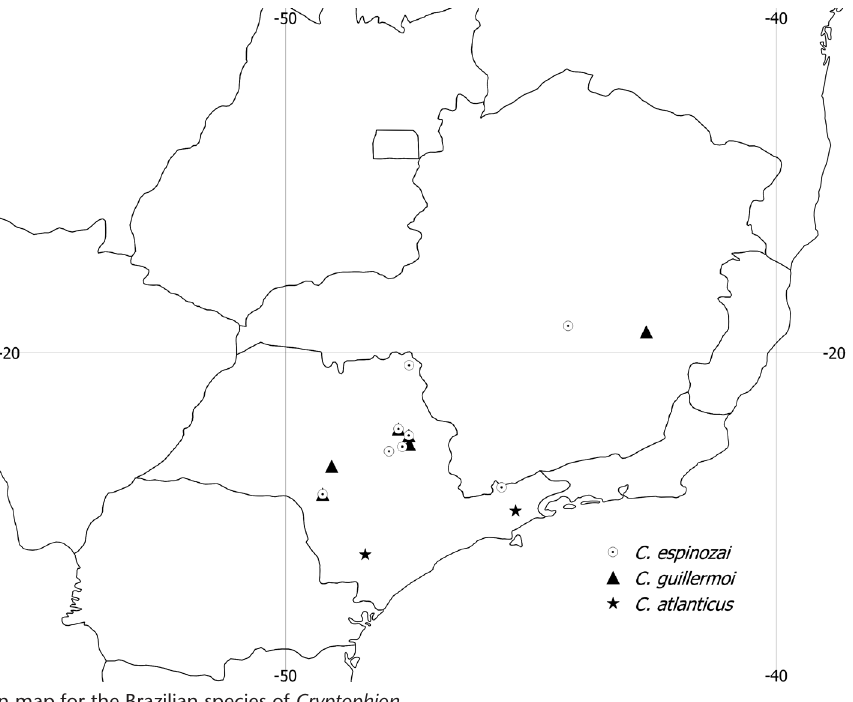
Figure 7. Distribution map for the Brazilian species of Cryptophion .